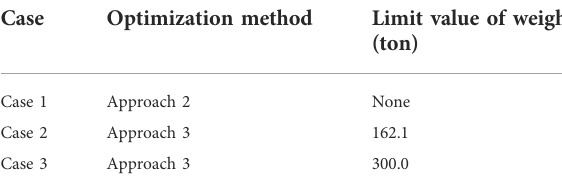
TABLE 5 Optimization cases with three